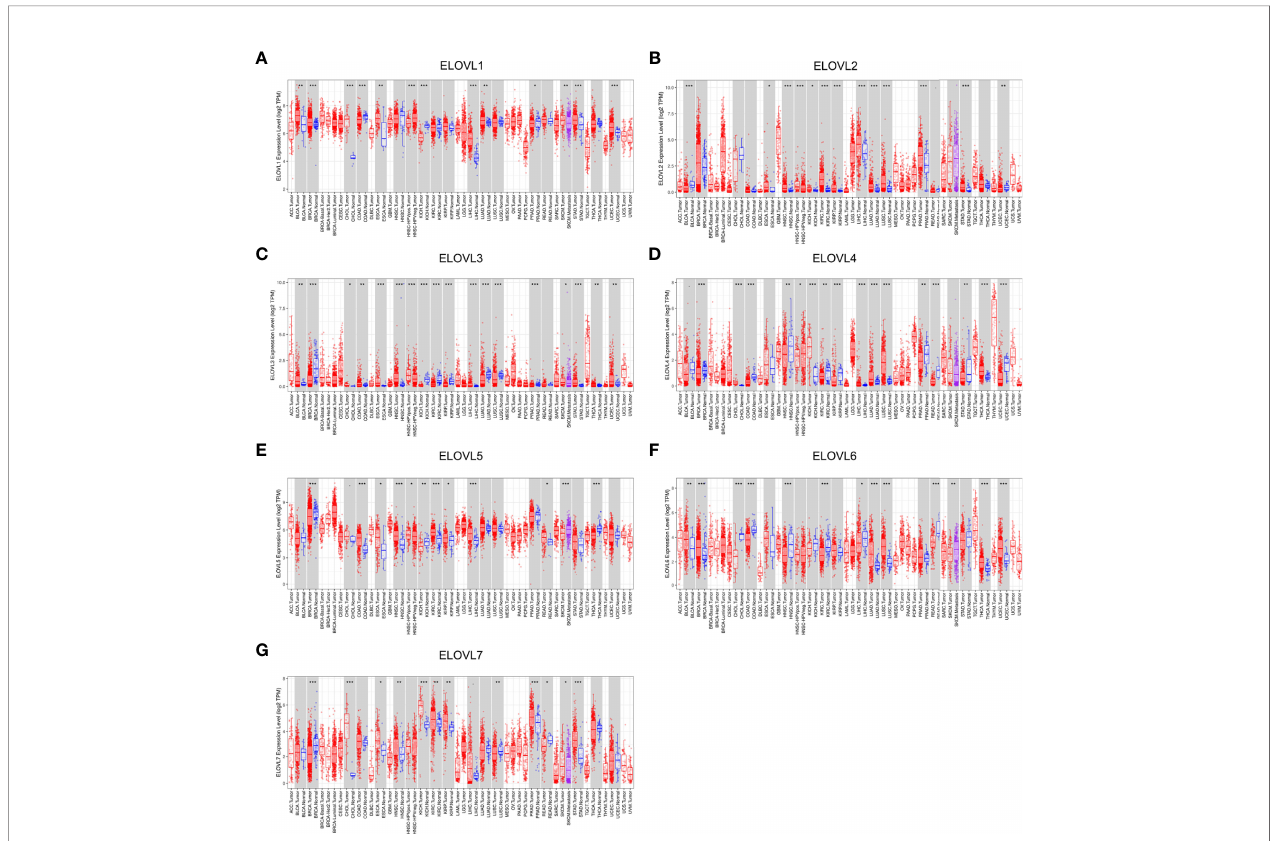
FIGURE 1 | The mRNA expression of ELOVLs family in pan-cancer level. (A – G) ELOVLs family in various cancers was detected by TCGA database. *P < 0.05, **P< 0.01, and ***P <